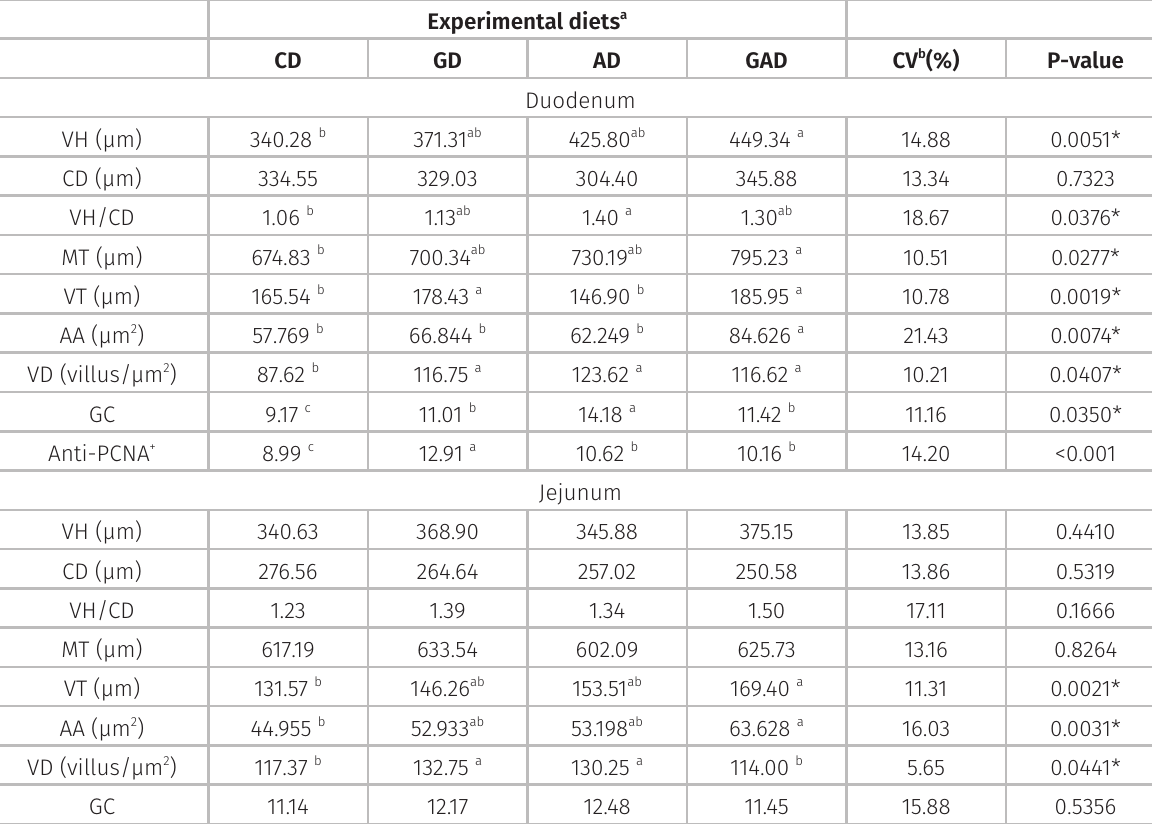
Table V. Mean villus height (VH), crypt depth (CD) and villus height:crypt depth ratio (VH/CD), mucosa thickness (MT), villus thickness (VT), absorptive area (AA), villus density per area (VD), goblet cell count (GC) and anti-PCNA + cell count of the duodenum and jejunum of piglets fed L-glutamine + glutamic acid and